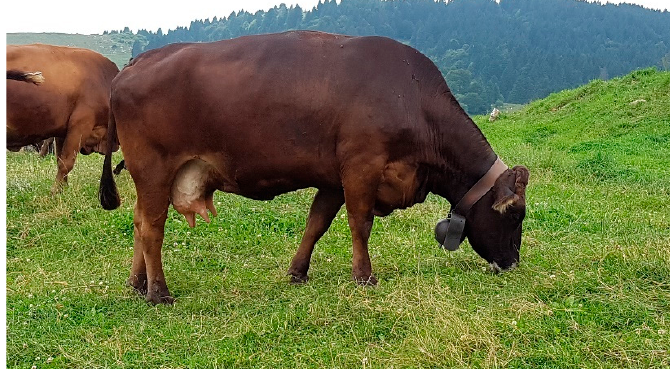
Figure 1. Cow of Rendena breed at pasture (photo of R. Mantovani).